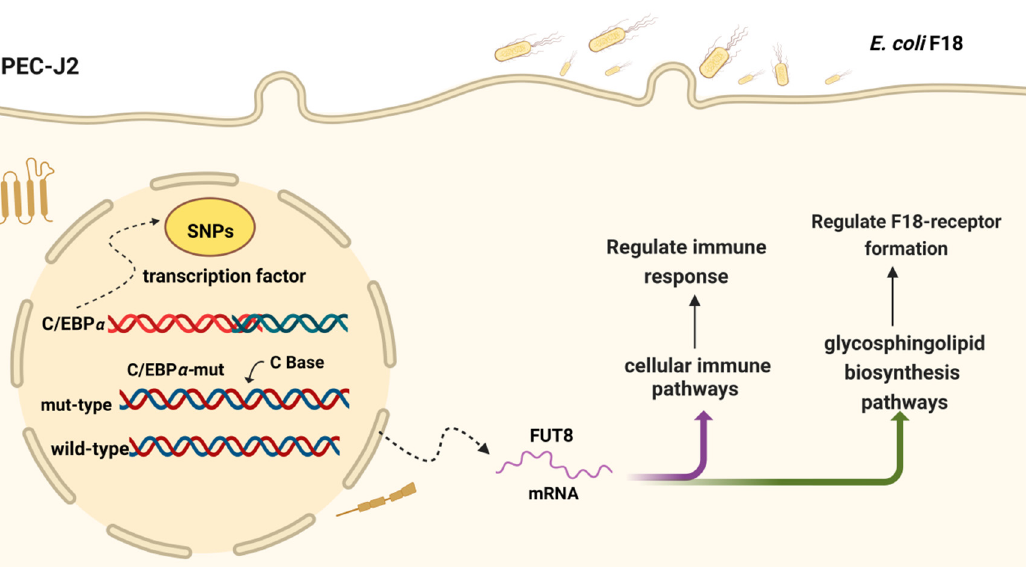
Figure 8. The diagram of the regulation mechanism of E. coli F18 infection of the FUT8 gene in IPEC-J2 cells.